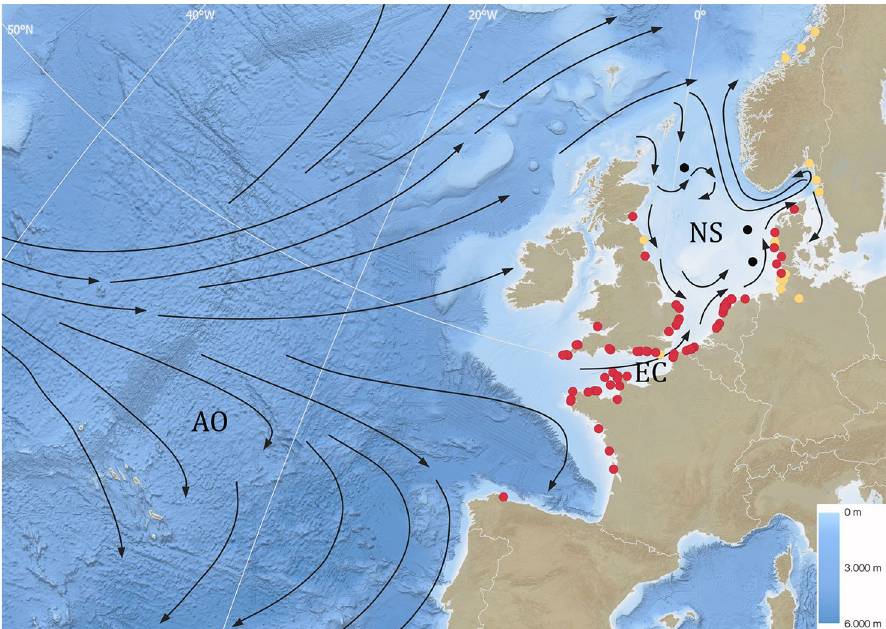
Figure 1. Bathymetric map of the North Sea (NS), English Channel (EC) and north-eastern part of the Atlantic Ocean (AO). The dominant surface currents are indicated with black arrows (figure based on reports from the European Environment Agency; https:// www. eea. europa. eu/ publi catio ns/ report_ 2002_ 0524_ 154909). The retrieval positions of the PDSTs and pop-off positions of the three PSATs are indicated with dots (red: Belgian eels, yellow: German eels; black: PSAT pop-off positions). The legend of the bathymetry is indicated in the bottom right